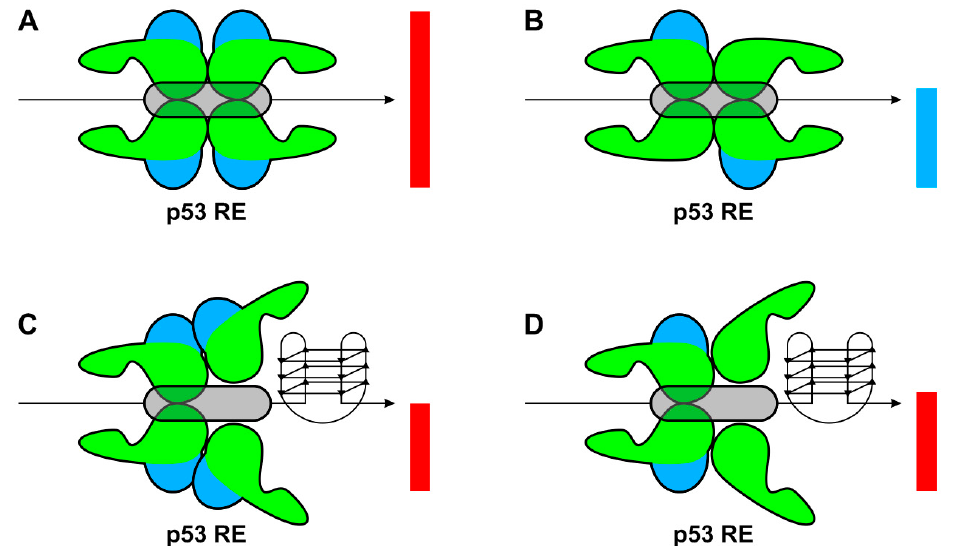
Figure 8. Schematic model of p53 isoforms binding to a RE associated with G4 sequence. ( A ) FLp53 α or ∆ 40p53 α bind effectively to the RE and there is a high or moderate level of transactivation. ( B ) ∆ 133p53 α and ∆ 160p53 α inhibit FLp53 α transactivation, ( C ) the presence of a G4 close to the RE decreases accessibility of the TA domains and FLp53 α transactivation, ( D ) which is not more inhibited by ∆ 133p53 α and ∆ 160p53 α , although steric protein orientation is impaired due to the G4 structure. TA is the blue domain, rest of the protein is in green, column represent transactivation induced by p53 complex (red column FLp53 α , blue FLp53 α with ∆ 133p53 α and ∆ 160p53 α isoforms).